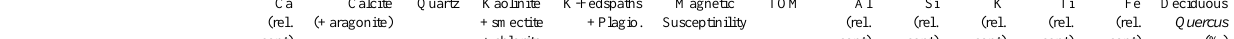
Table 3. Significant simple linear correlation coefficients ( p < 0.001) between environmental variables from Yammoˆuneh. Ca Calcite Quartz Kaolinite K-Fedspaths Magnetic TOM Al Si K Ti Fe Deciduous (rel. (+aragonite) +smectite +Plagio. Susceptinility (rel. (rel. (rel. (rel. (rel. Quercus cont) +chlorite cont) cont) cont) cont) cont)